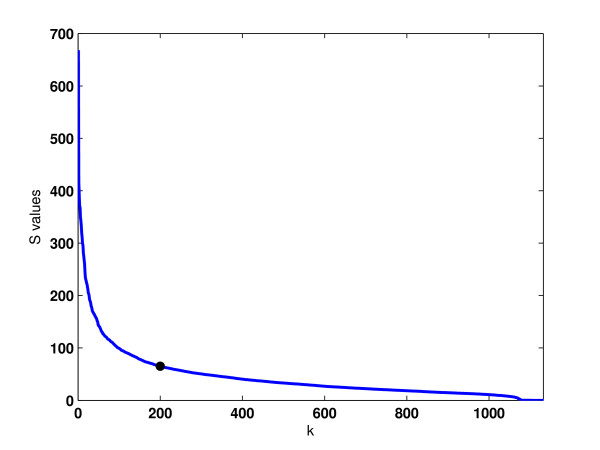
Singular values. Singular values corresponding to full-rank SVD factorization (as obtained in S matrix) ordered in decreasing magnitude. X axis corresponds to diagonal index. First k = 200 largest were kept according to scree test.